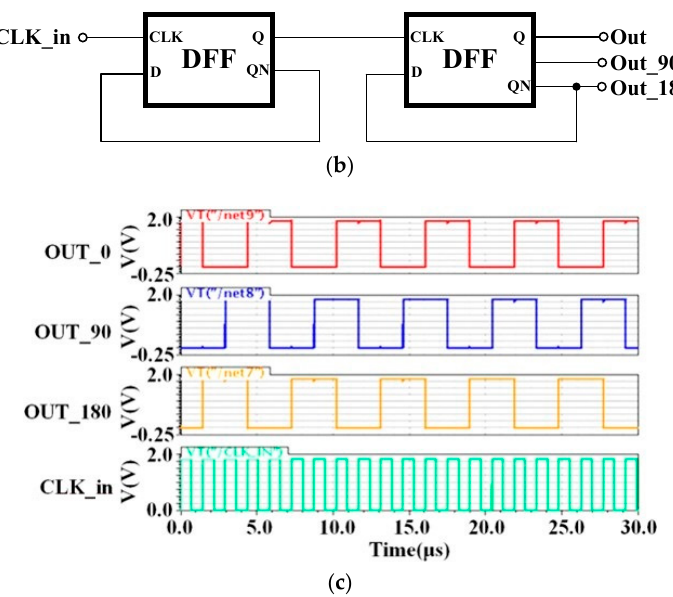
Figure 10. ( a ) D-flip-flop logic diagram; ( b ) Divide-by-four block diagram; ( c ) Divide-by-four simulation results.